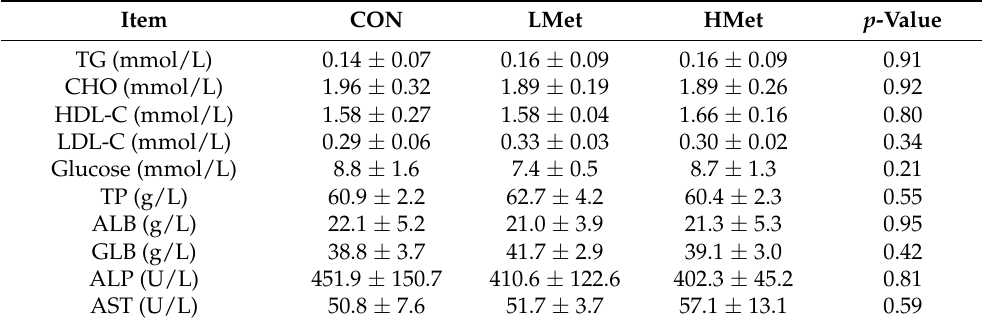
Table 3. Effect of methionine supplementation on serum biochemical indexes in sika deer.